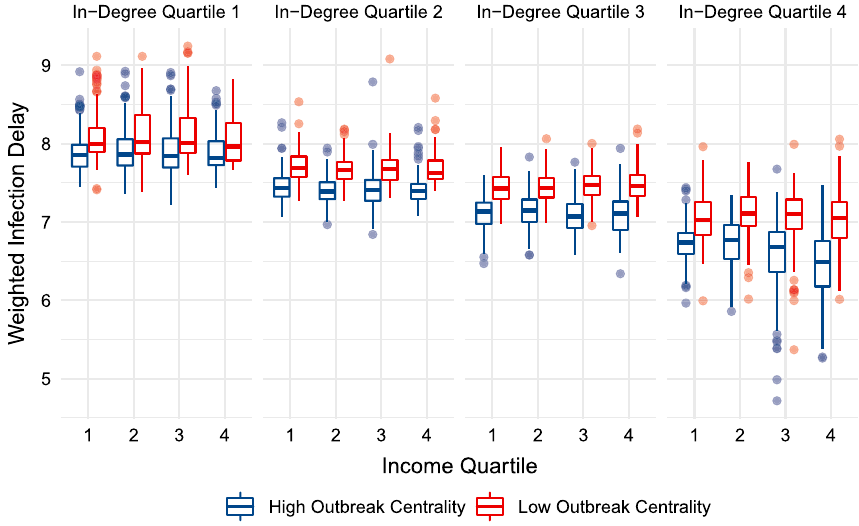
Fig. 11 Un-weighted infection delay values across income quartiles, while controlling for in-degree centrality. Each region’s infection delay values are calculated and displayed for outbreak scenarios in the upper and lower 50% of in-degree